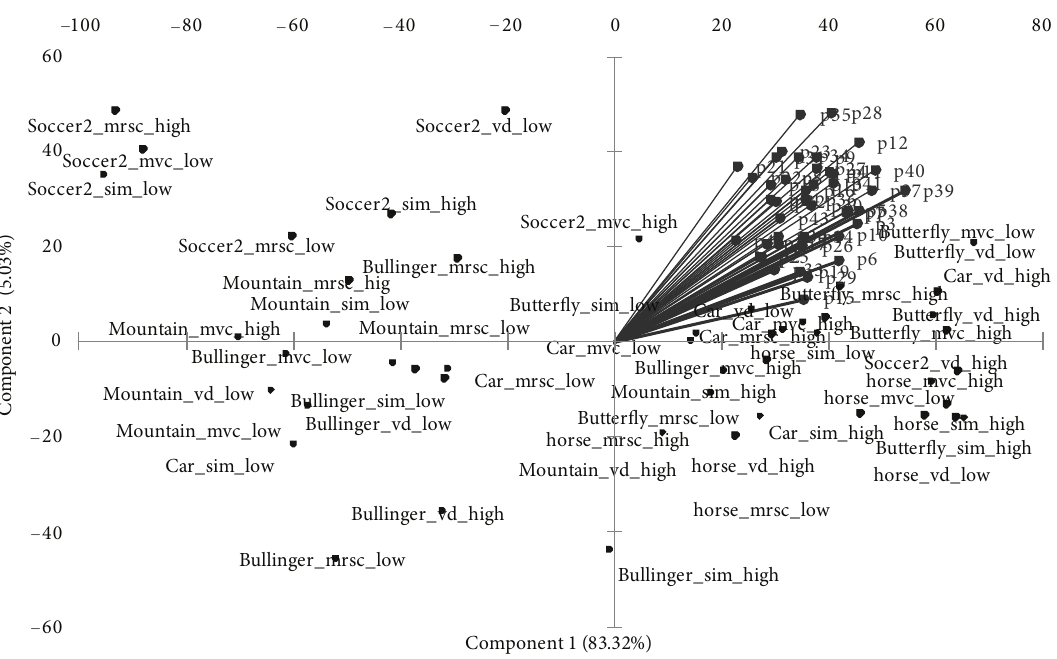
Figure 14: The item plot of the GPA model showing the first two principal components and the test items within the space. Gray arrows mark users’ preferences which were mapped into the model using PREFMAP.